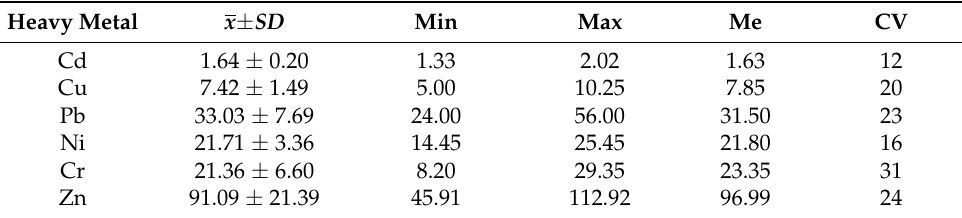
Table 6. Content of trace metals in the sediments of Lake Bukwałd (mg · kg − 1 of dry matter). Heavy Metal